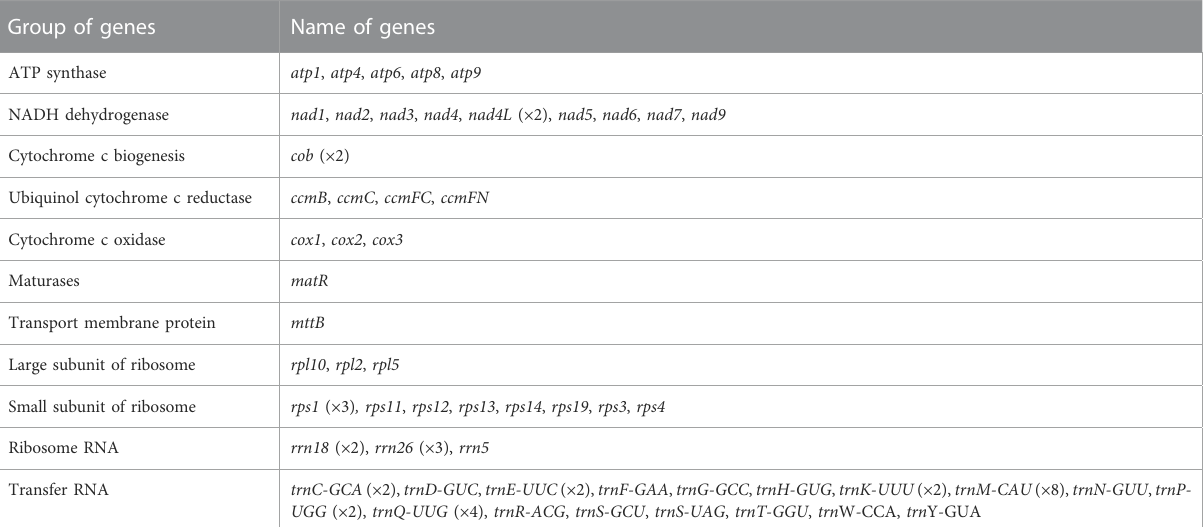
TABLE 1 Gene composition in the C. acerifolia.